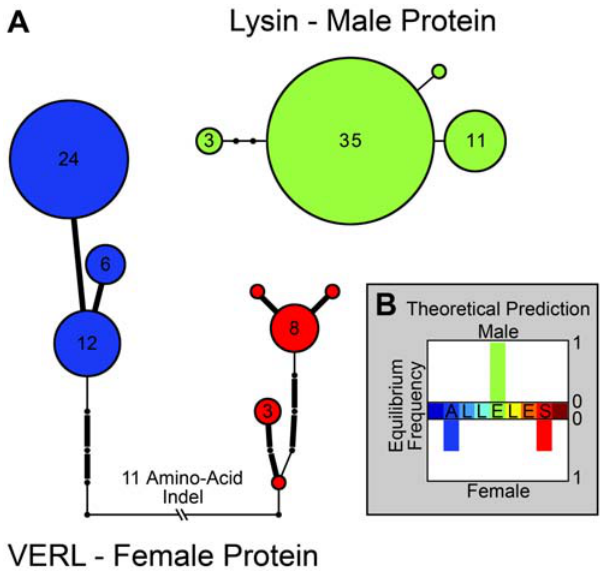
Figure 3. Polymorphisms in lysin and VERL match a unique prediction of sexual conflict. (A) In these haplotype networks, each pink abalone haplotype is a node with size proportional to allele frequency. Absolute frequencies are given inside each node. Edges between nodes are substitutions; edges representing nonsynonymous substitutions are in bold. The lysin network is of the largest region ( , 1 kb) with no observed recombination events. Notably, there are no amino acid polymorphisms in the entire coding sequence of lysin. The VERL network was constructed using all 306 resequenced nucleotides in the last repeat. The two divergent clades of VERL alleles do not reject Hardy-Weinberg equilibrium. (B) Models of sexual conflict predict that female diversification can reduce rates of polyspermy. One possible outcome of these models is diagrammed. Bars represent the predicted equilibrium frequencies of alleles in males and females. Maximally compatible alleles have the same value (color) on the x-axis (ALLELES). Males are prevented from specializing on one group of females by frequency dependent selection. Shifting the mean male phenotype toward either group of females results in a benefit to and increase in the frequency of alleles in the other group of females. Diagram adapted from Gavrilets and Waxman